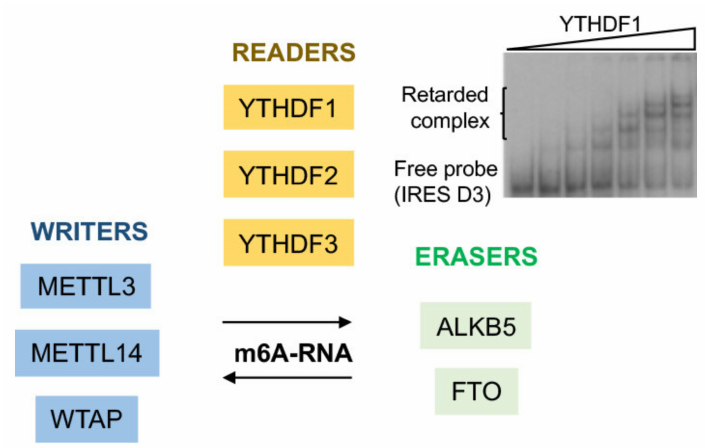
Figure 5. Diagram of m 6 A RNA modification enzymes. The proteins known as writers, readers, and erasers are depicted. The image on the right shows the interaction of YTH N6-methyladenosine RNA binding protein 1 (YTHDF1) protein with labeled domain 3 the FMDV IRES in RNA retarded gel shift